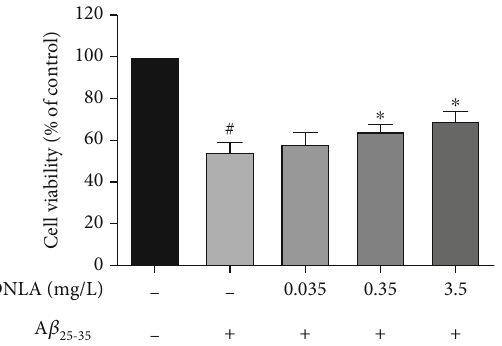
Figure 2: E ff ect of DNLA on cell viability induced by A β PC12 cells. The cell viability in PC12 cell damage induced by A β after treatment with DNLA ( n = 6 , (cid:1) x ± s ). Note: # P < 0 : 05 25-35 vs. control; ∗ P < 0 : 05 vs.